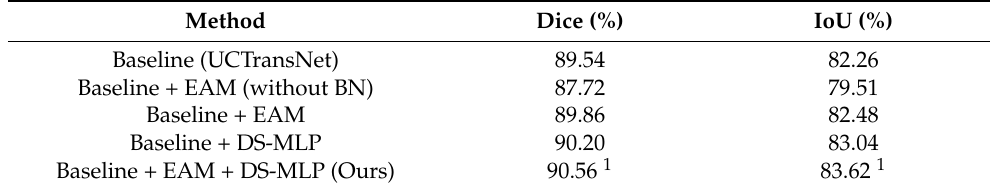
Table 3. Ablation experiments on GlaS datasets. The superscript “1” indicates the best experimen- tal result.